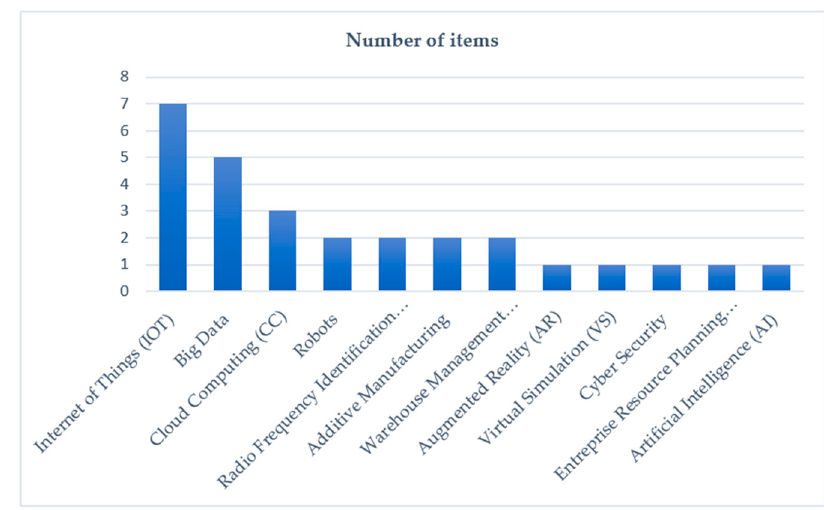
Figure 2. Number of publications of 4.0 technologies used in VSM4.0 .